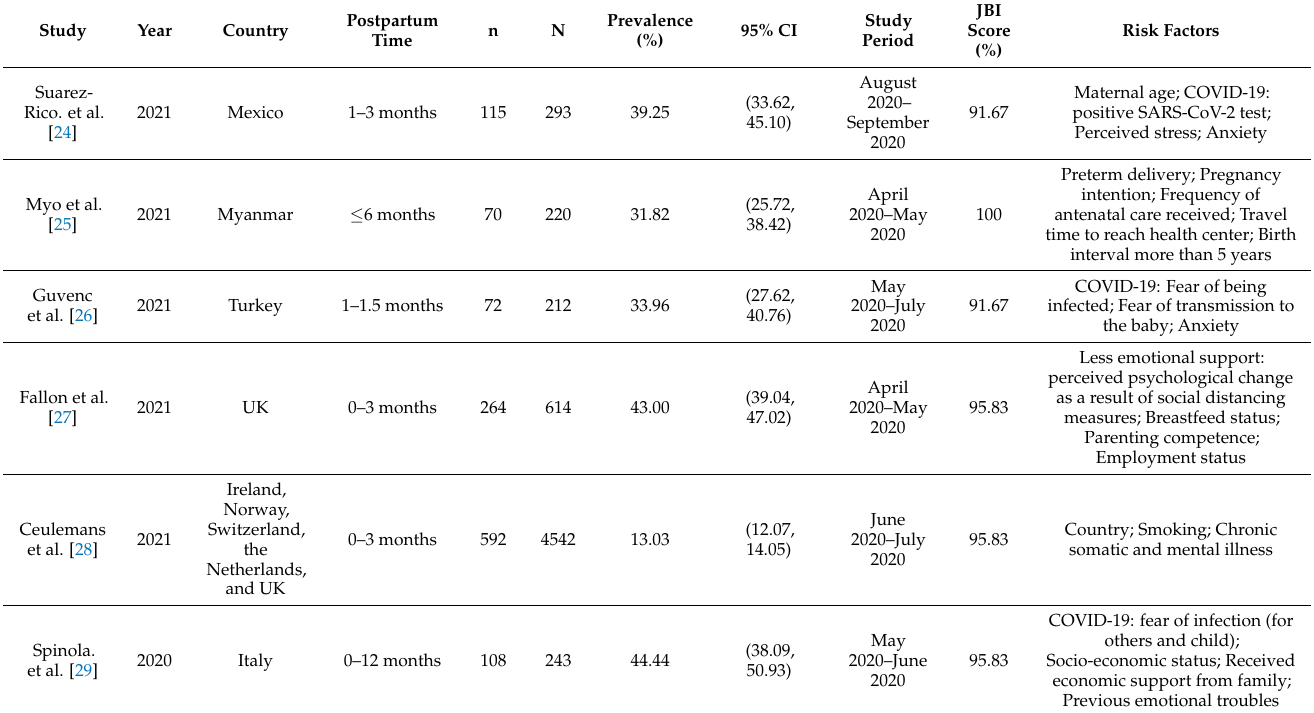
Table 1. Characteristics of included studies on PPD and its risk factors during the COVID-19 pandemic.